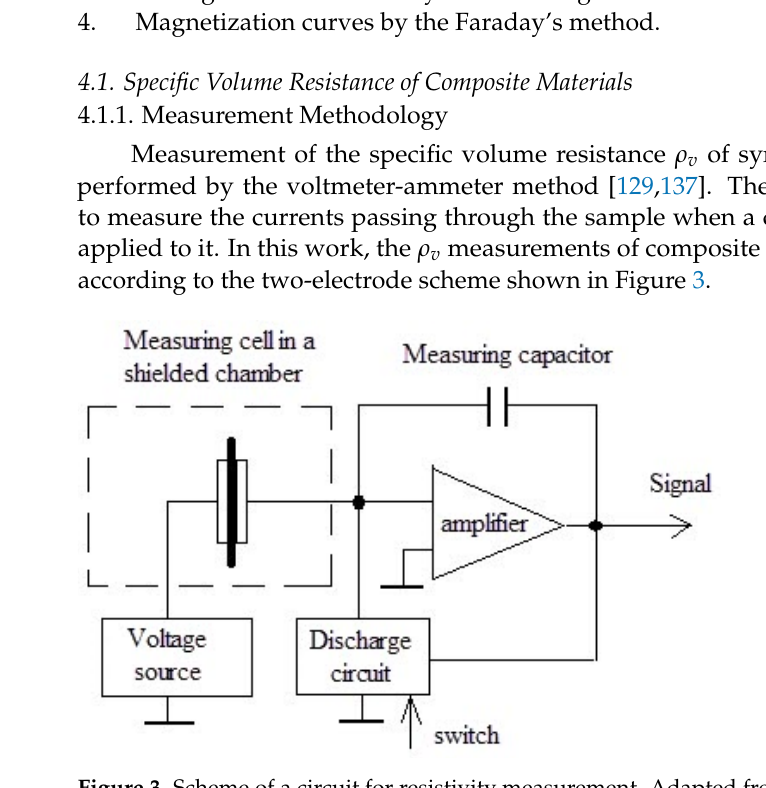
Figure 3. Scheme of a circuit for resistivity measurement. Adapted from [129] with permission.